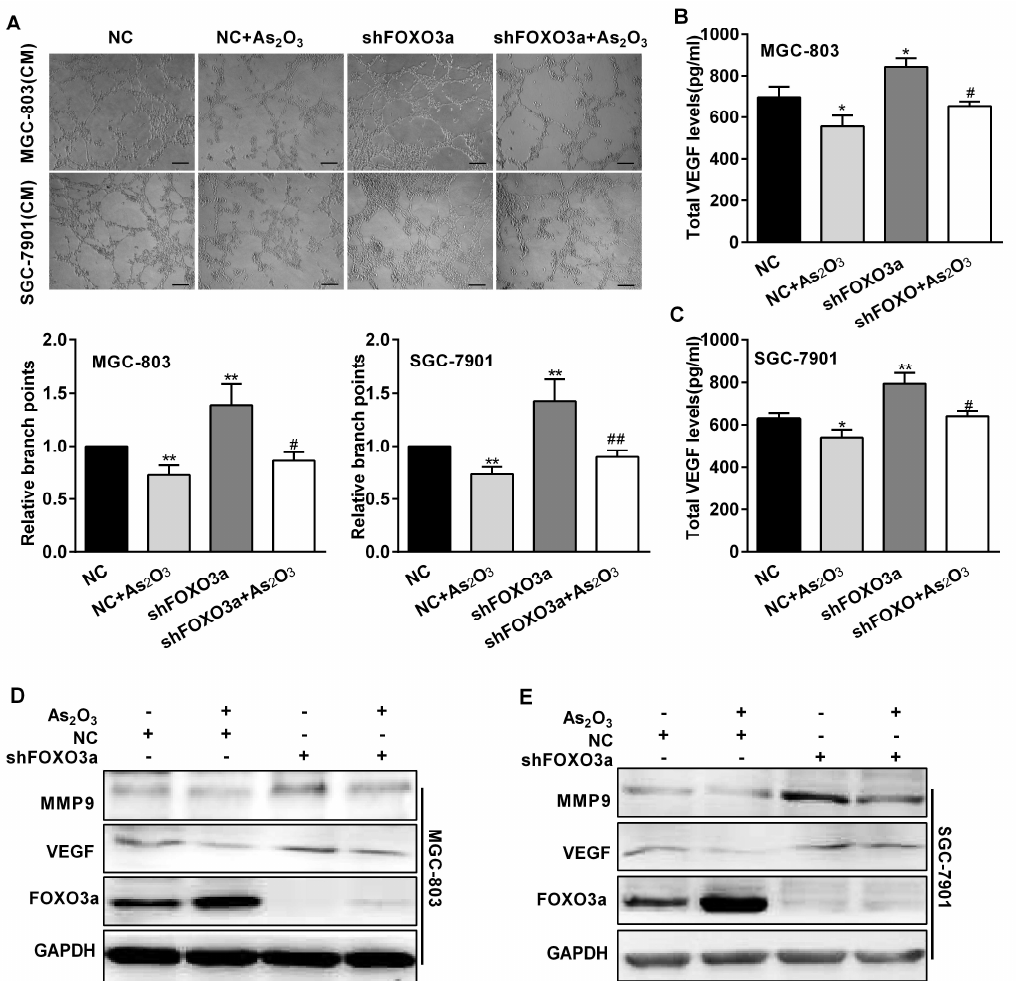
Figure 4. FOXO3a mediated the inhibitory effect of As 2 O 3 on angiogenesis in vitro. ( A ) Tube formation assays detected formed tubes of HUVECs treated with CM from MGC-803 and SGC-7901 cells transfected with negative control shRNA or shFOXO3a. Calculating branch points per field was used to quantify the ability of tube formation. Scale bar, 100 μm. ( B , C ) ELISA analysis detected total VEGF protein secretion in these cells. All data were obtained from three independent experiments. ( D , E ) The expression of MMP9 and VEGF was detected by western blotting. Compared with the NC group, * p < 0.05, ** p < 0.01; compared with NC + As 2 O 3 group, # p < 0.05, ## p < 0.01.